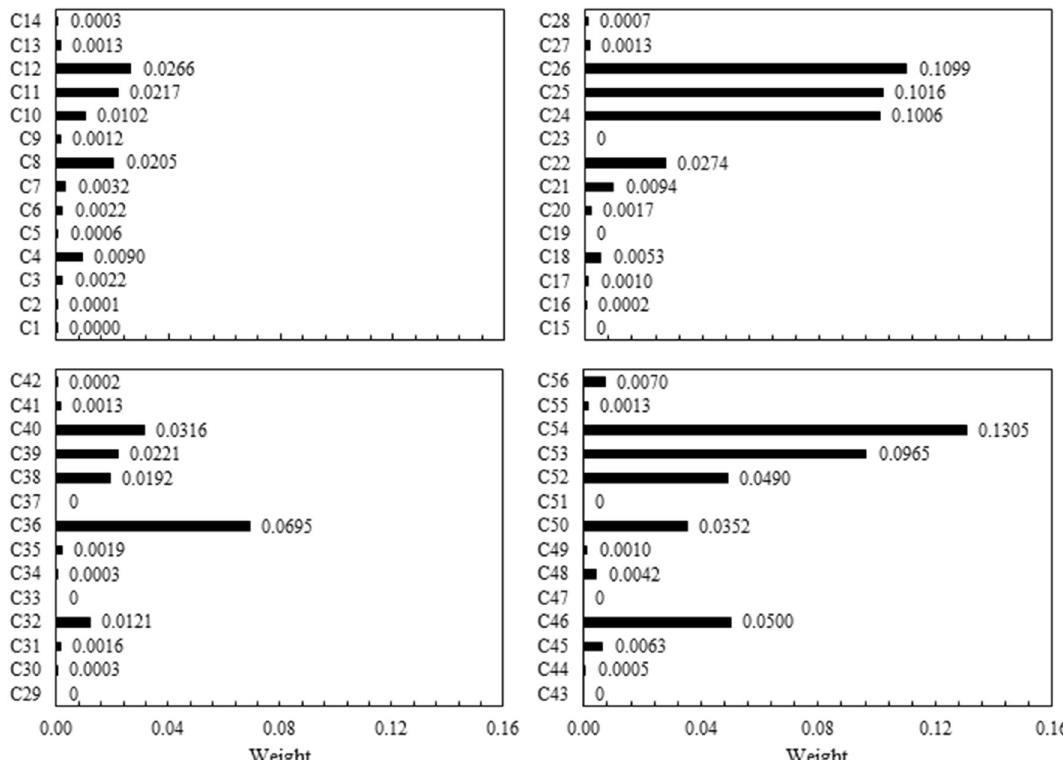
Figure 9. Weights assigned to the evaluation criteria.